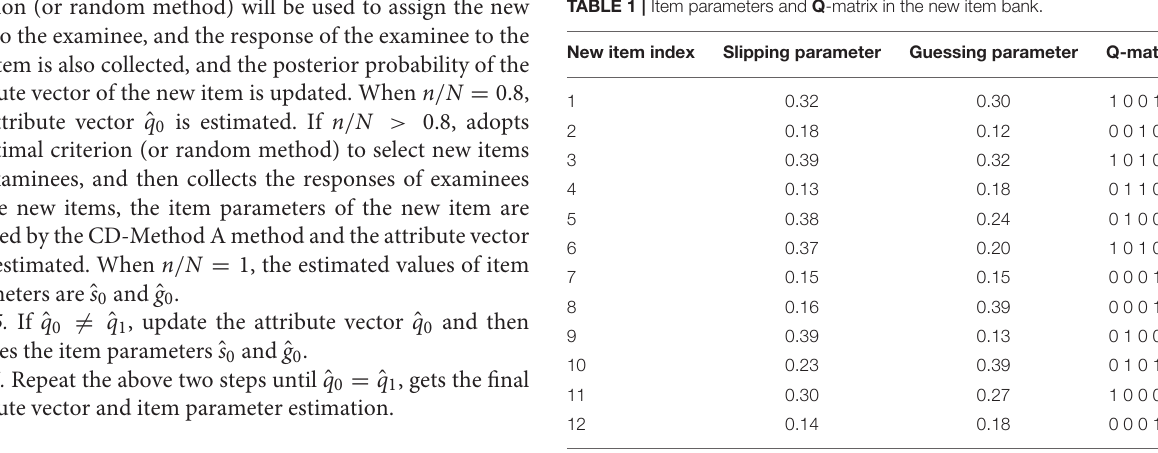
TABLE 1 | Item parameters and Q -matrix in the new item